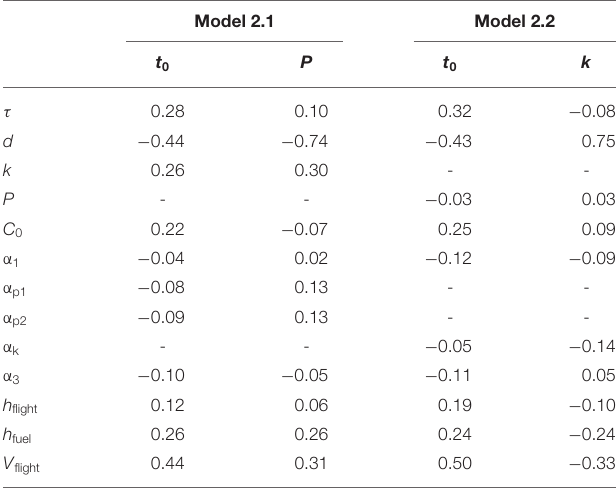
TABLE 1 | Correlations (r) between parameters and decision variables ( t 0 , P , k ) in randomized simulations of migration models 2.1 and